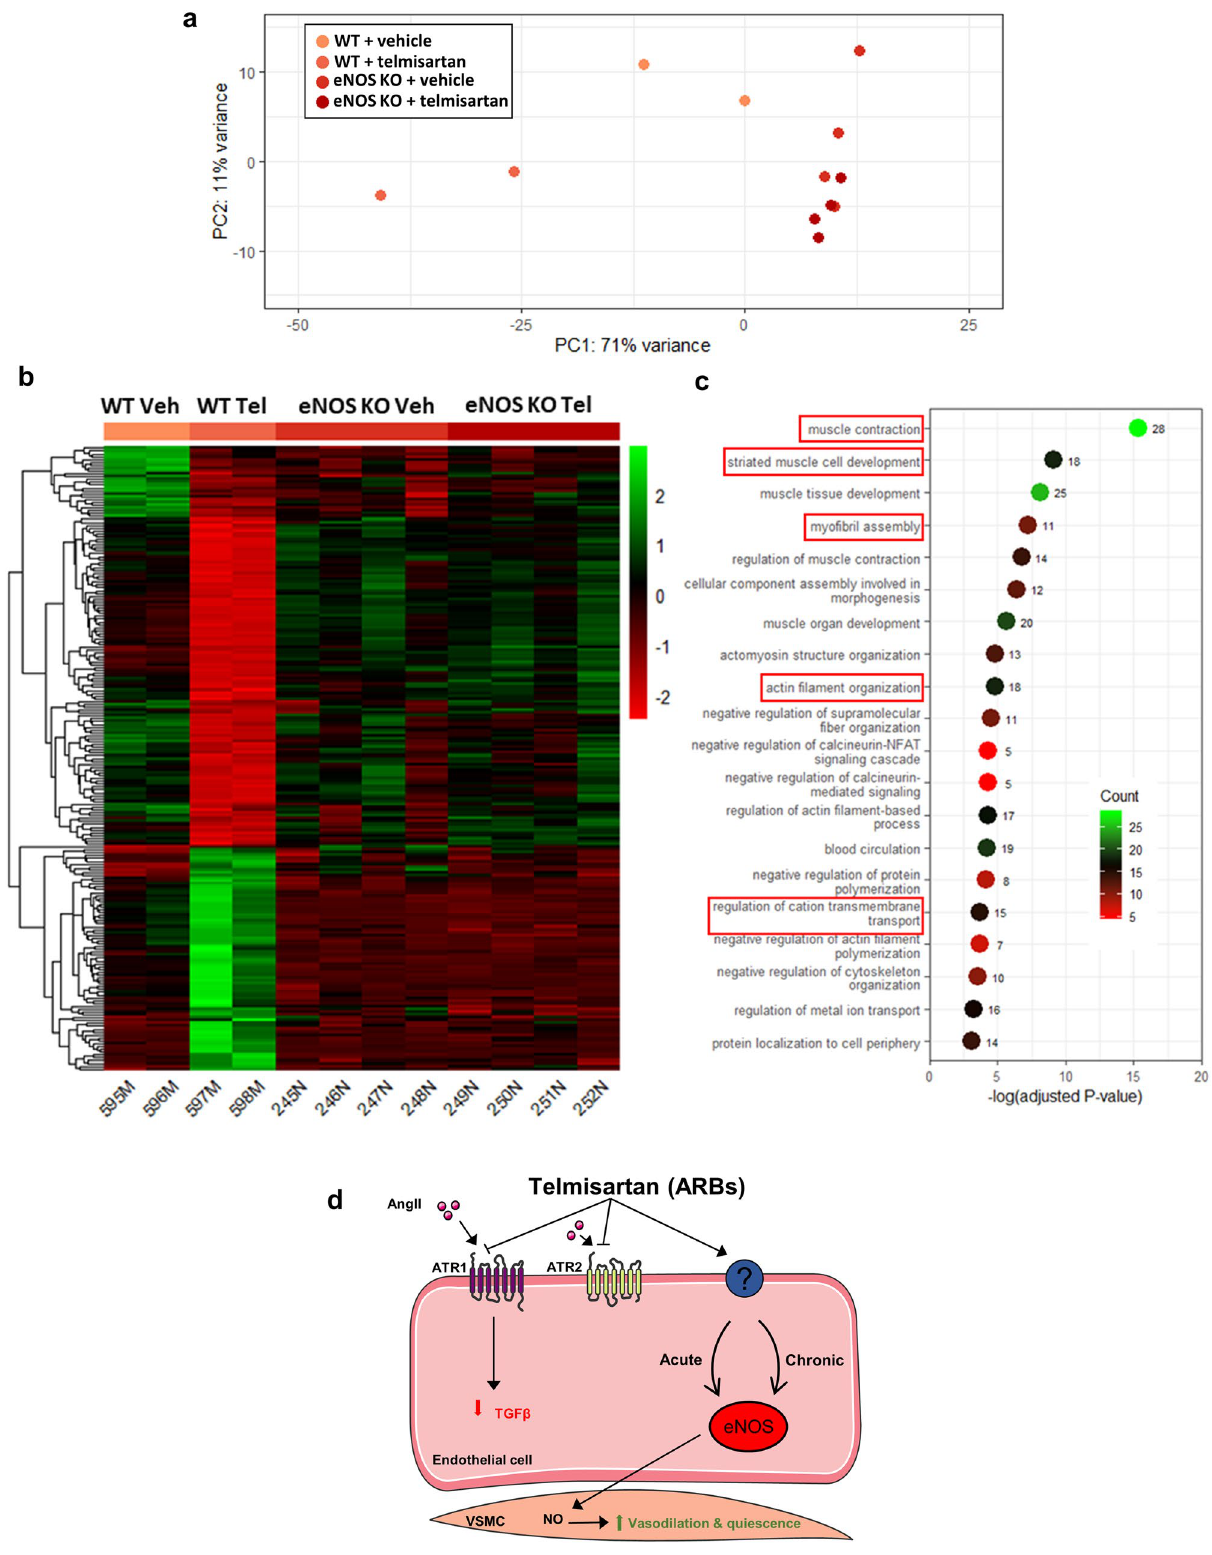
Figure 8. Effect of telmisartan on eNOS-dependent gene signature changes by RNA-seq. ( a ) Principle component analysis (PCA) of the transcripts detected in aortic tissues isolated from WT and eNOS KO mice. ( b ) Expression clustering of samples and regions significantly different between untreated and treated WTs but not significantly different between untreated and treated eNOS KO mice. ( c ) Top 20 gene ontology (GO) terms with the number of associated DEGs related to eNOS-dependent pathways regulated by telmisartan in the mouse aorta. (WT n = 2, WT + telmisartan n = 2, eNOS KO n = 4, eNOS KO + telmisartan n = 4). ( d ) Mechanistic overview of how ARBs/ telmisartan act on eNOS and how this goes on to also have protective effects on vascular